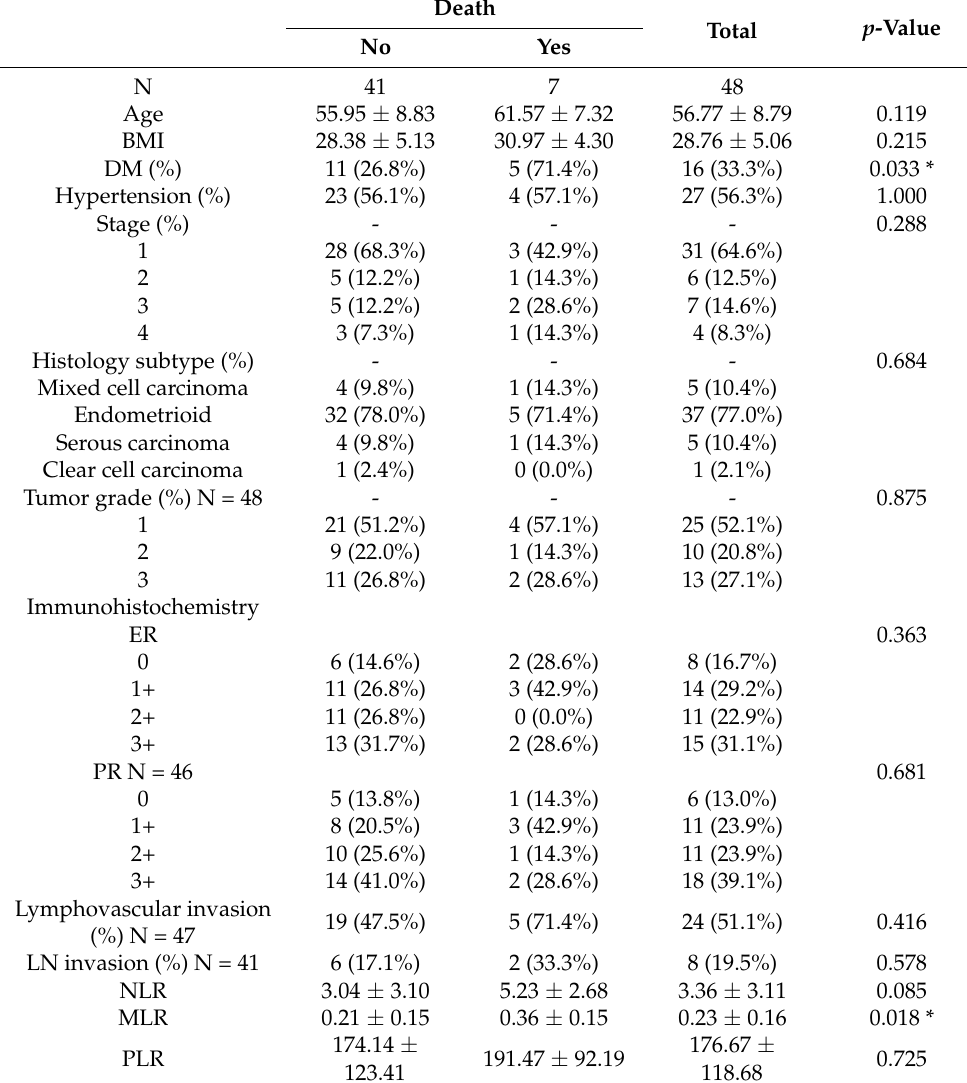
Table 1. Demographic characteristics of patient data involved in the study ( n =